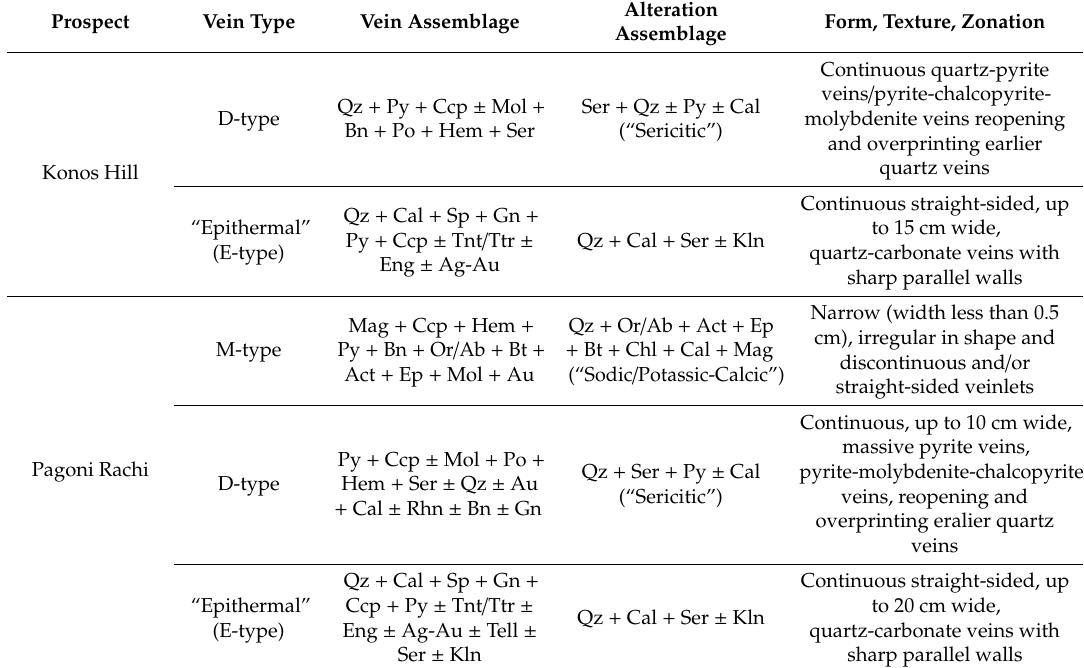
Table 1. Typology and alteration characteristics of pyrite-bearing mineralization stages analyzed in the present study, from the Konos Hill and Pagoni Rachi porphyry / epithermal prospects.